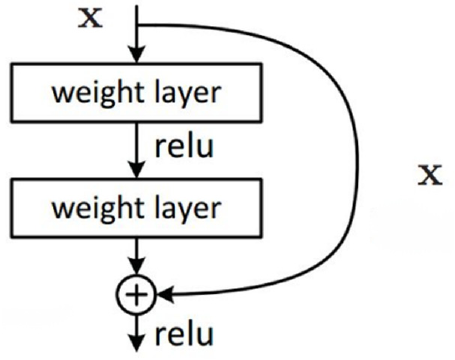
Figure 1. Residual Network.